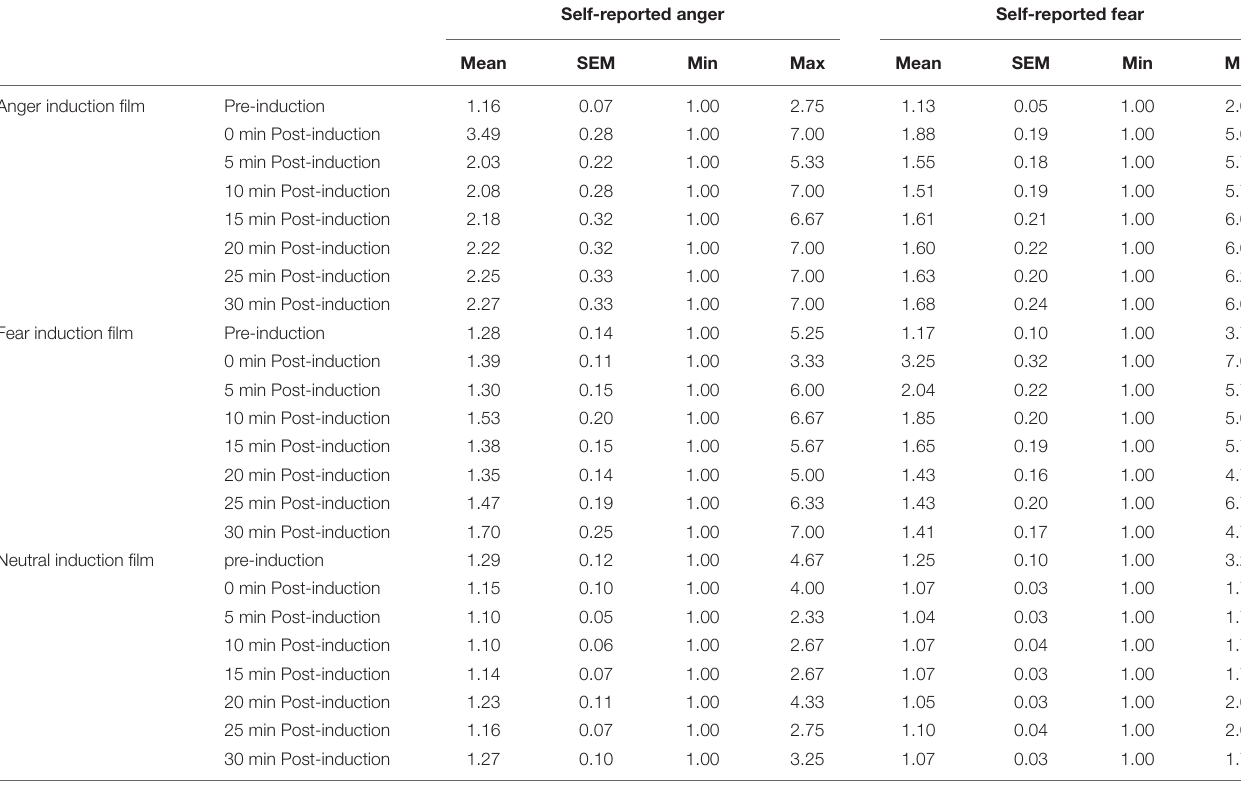
TABLE 2 | Study 1 self-reported anger and fear before, during, and after anger, fear, and neutral motivational state inductions ( n =